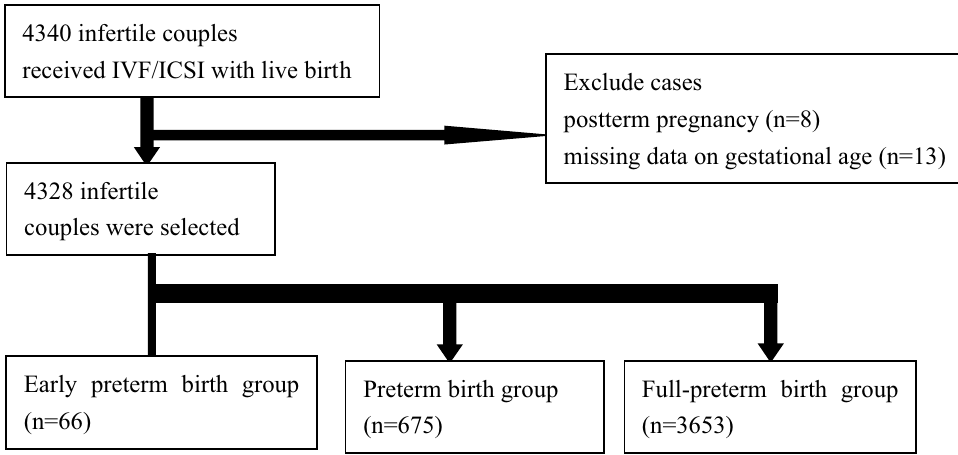
Figure 1. Study flow chart. Early preterm birth group: 20 weeks ≤ gestational age < 32 weeks; preterm birth group: 20 weeks ≤ gestational age < 37 weeks; full-term birth group: 37 weeks ≤ gestational age < 42